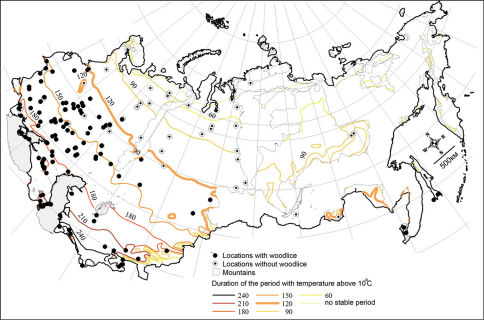
Map of woodlice presence or absence over the plain territory of the former USSR. The duration of period with temperature >10°C is adapted from Geographical Atlas of the USSR (Kolosova 1980).